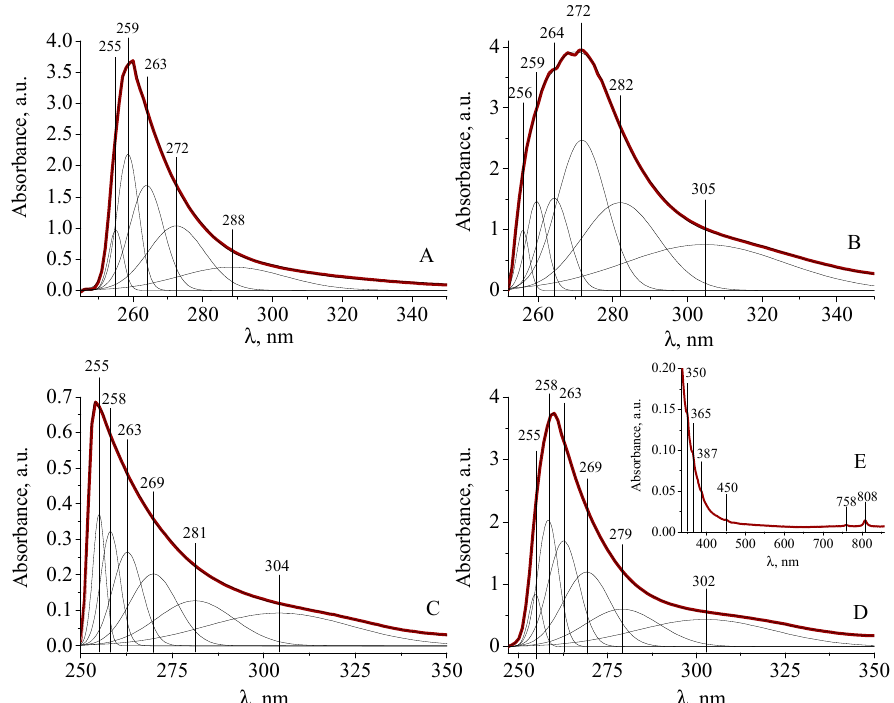
Figure 6. Electronic absorption spectra of compounds 1 and 2 , interpolated from the Gaussian distribution function in the wavelength regions 250–350 ( A ) and 245–350 nm ( B ) in DMSO, c 1,2 = 1 × 10 – 3 mol ∙ L –1 ; Gd(III) 3 and Dy(III) complexes 4 , interpolated from the Gaussian distribution function in the wavelength regions 250–350, c 3 = 5.0 × 10 − 4 ( C ) and 247–350 nm, c 4 = 5.0 × 10 − 3 mol ∙ L –1 ( D ), in the region from 335 nm to 860 nm ( E ) in DMSO. Table 1. Deconvolution of electronic spectra of compounds 1 , 2 and complexes Gd(III) 3, Dy(III) 4 in DMSO.